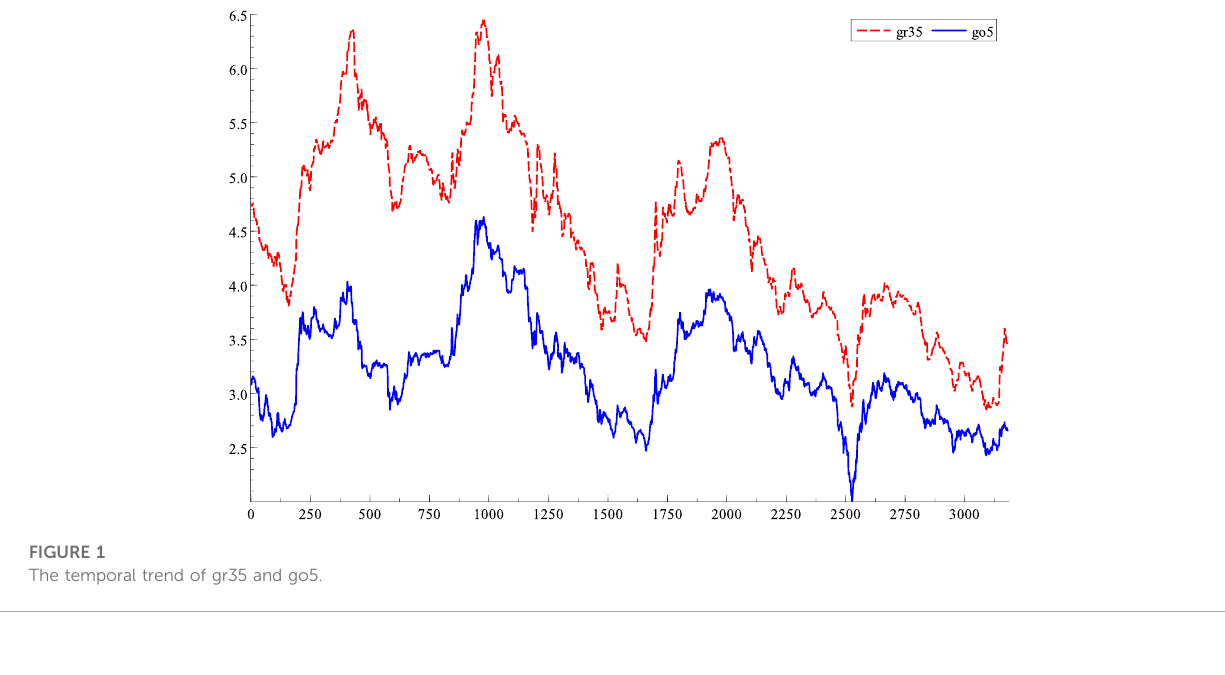
FIGURE 1 The temporal trend of gr35 and go5.